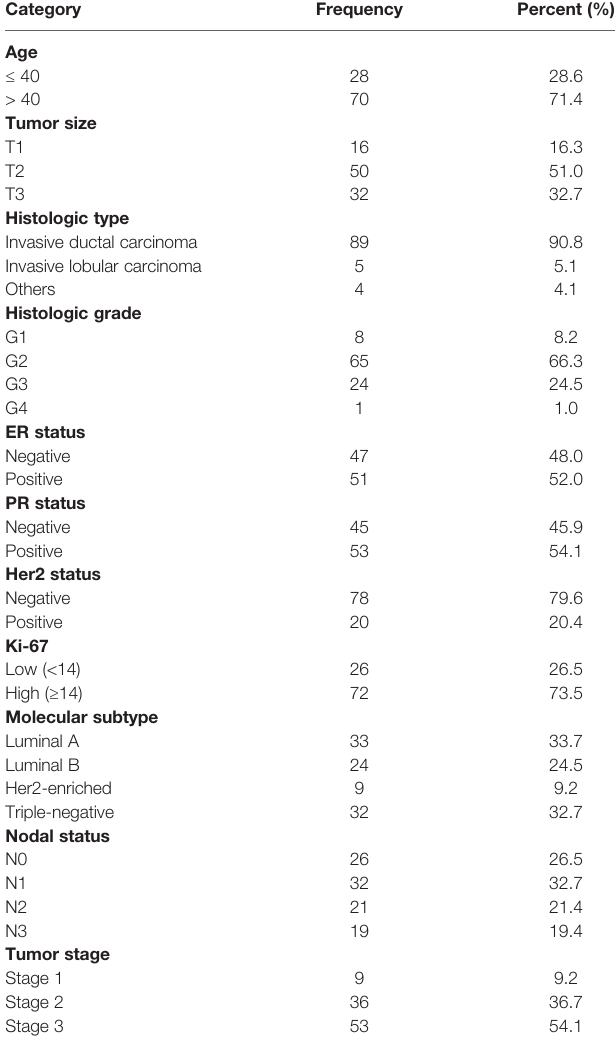
TABLE 1 | Clinicopathological characteristics of the recruited cohort of breast cancer patients (n = 98).